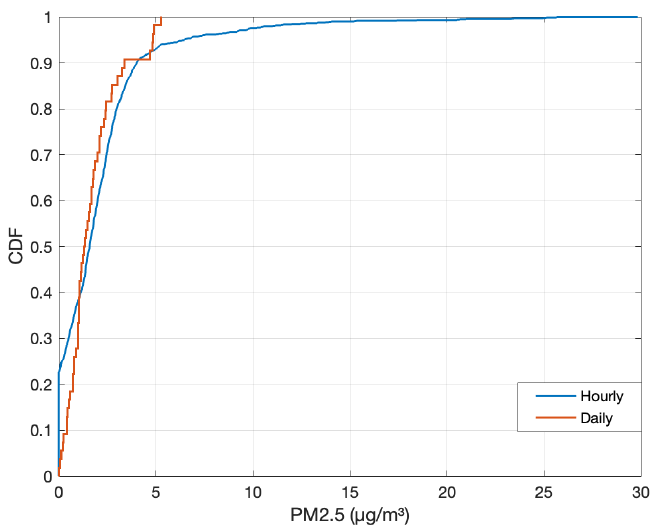
Figure 15. The accuracy of the Dustbox 2.0 compared to that of LAQN